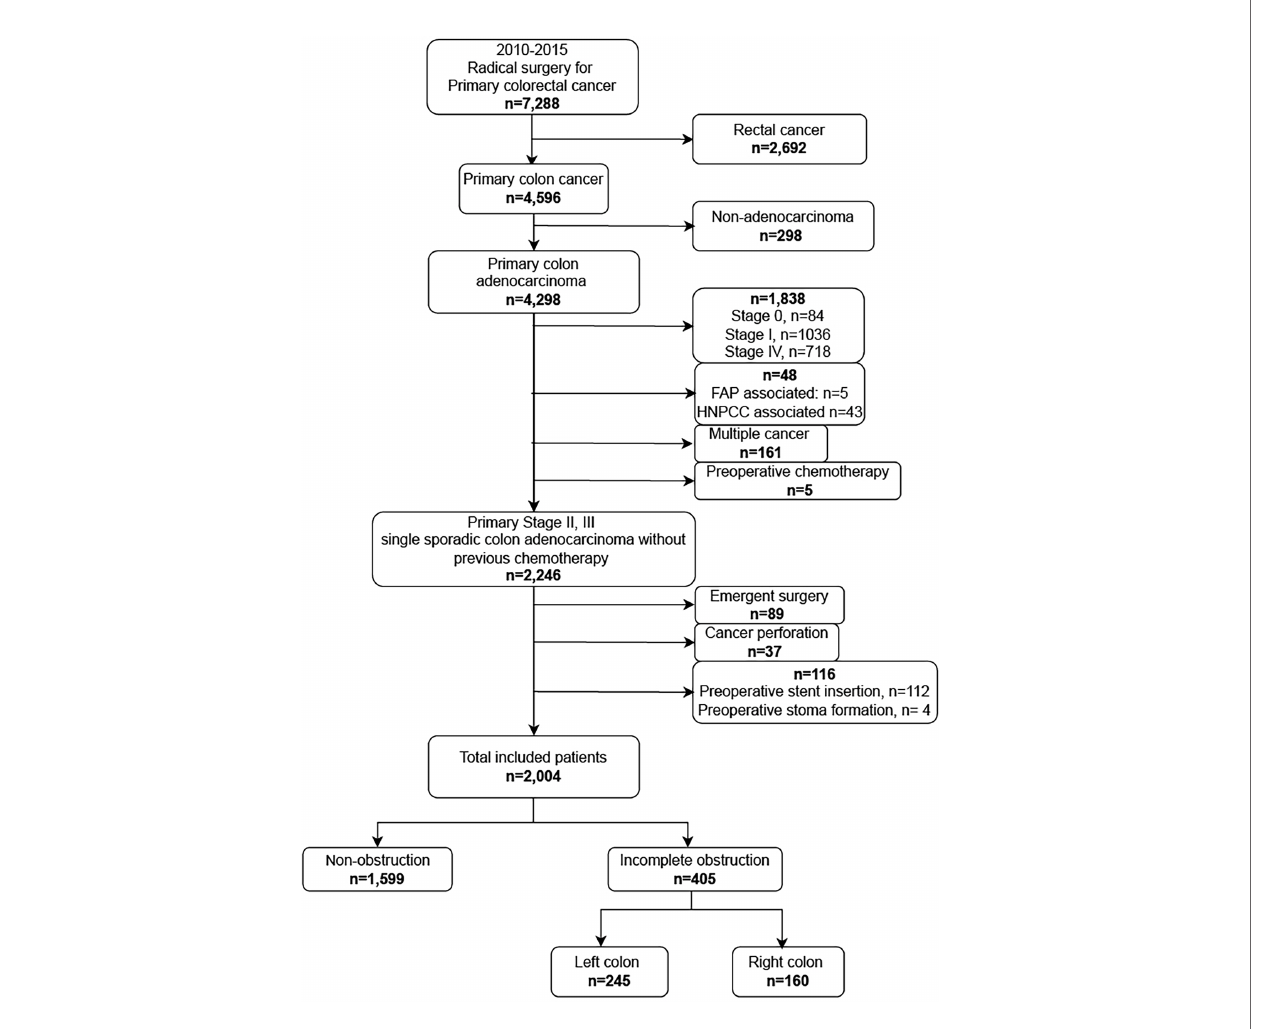
FIGURE 1 | Flowchart of the study indicating the inclusion and exclusion